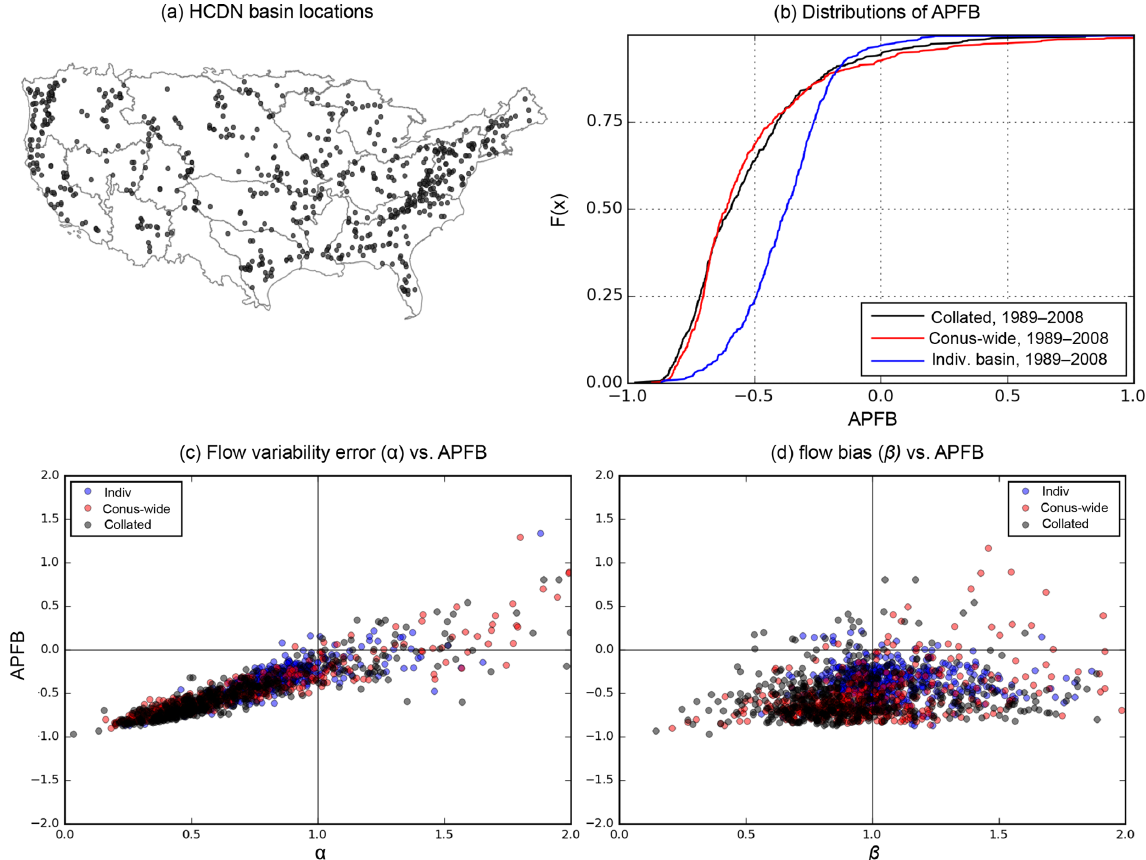
Figure 1. Spatial distribution of Hydro-Climate Data Network (HCDN) basins; (b) cumulative distribution of percent bias of annual peak flow (APFB) over 1989–2008 simulated with three different sets of VIC parameters used in Mizukami et al. (2017) at HCDN basins. (c) Relationships between variability error ( α : simulation-to-observation ratio of daily flow variability) and APFB. (d) Relationships between mean error ( β : simulation-to-observation ratio of mean flow) and